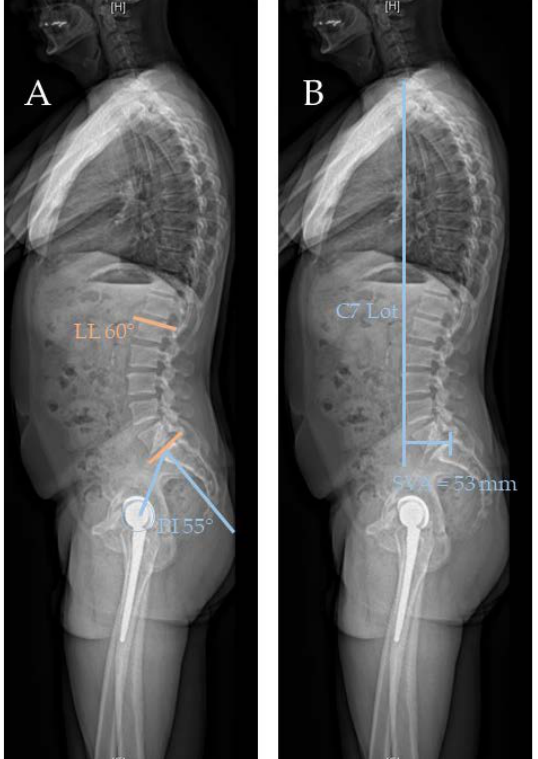
Figure 5. ( A ) Lateral standing radiograph with PI and LL used in PI and LL mismatch (PI–LL > 10°). ( B ) Lateral standing radiograph with C7 plumb line and sagittal vertical axis (SVA). This is an abnormal sagittal balance with an SVA larger than 20 mm.